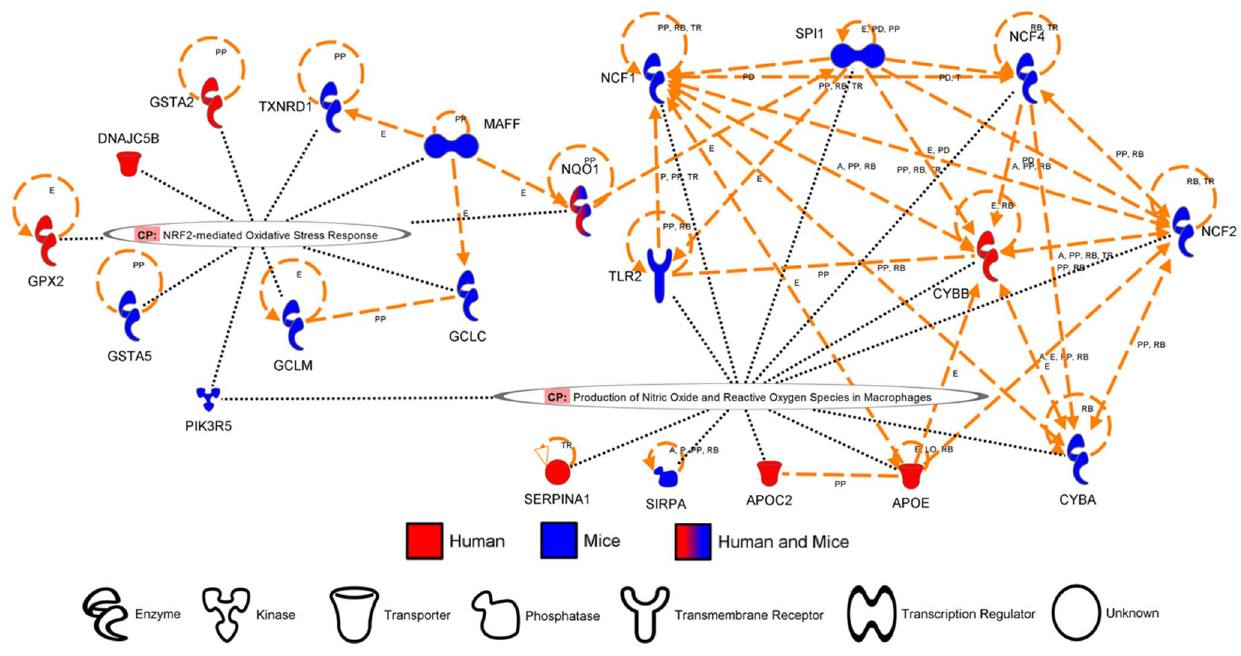
Figure 4. Genes associated to ‘‘Oxidative stress defense/generation’’ pathways modulated by cigarette smoke exposure in humans and mice. Orthologue genes significantly upregulated in humans and/or mice (fold change . 2) were used to predict canonical pathways activated by cigarette smoke exposure. Diagram generated using the Ingenuity Pathway Analysis Software.